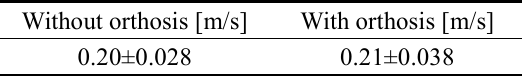
Table 3 Walking speed in the